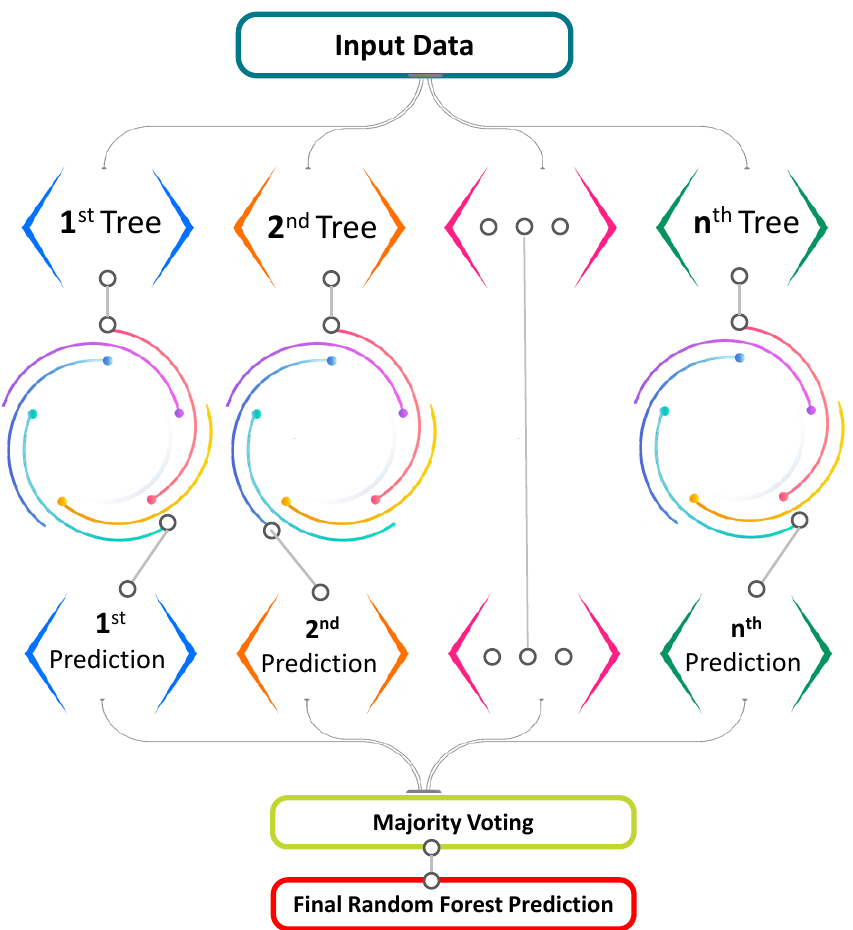
Figure 5. Random forest schematic diagram.